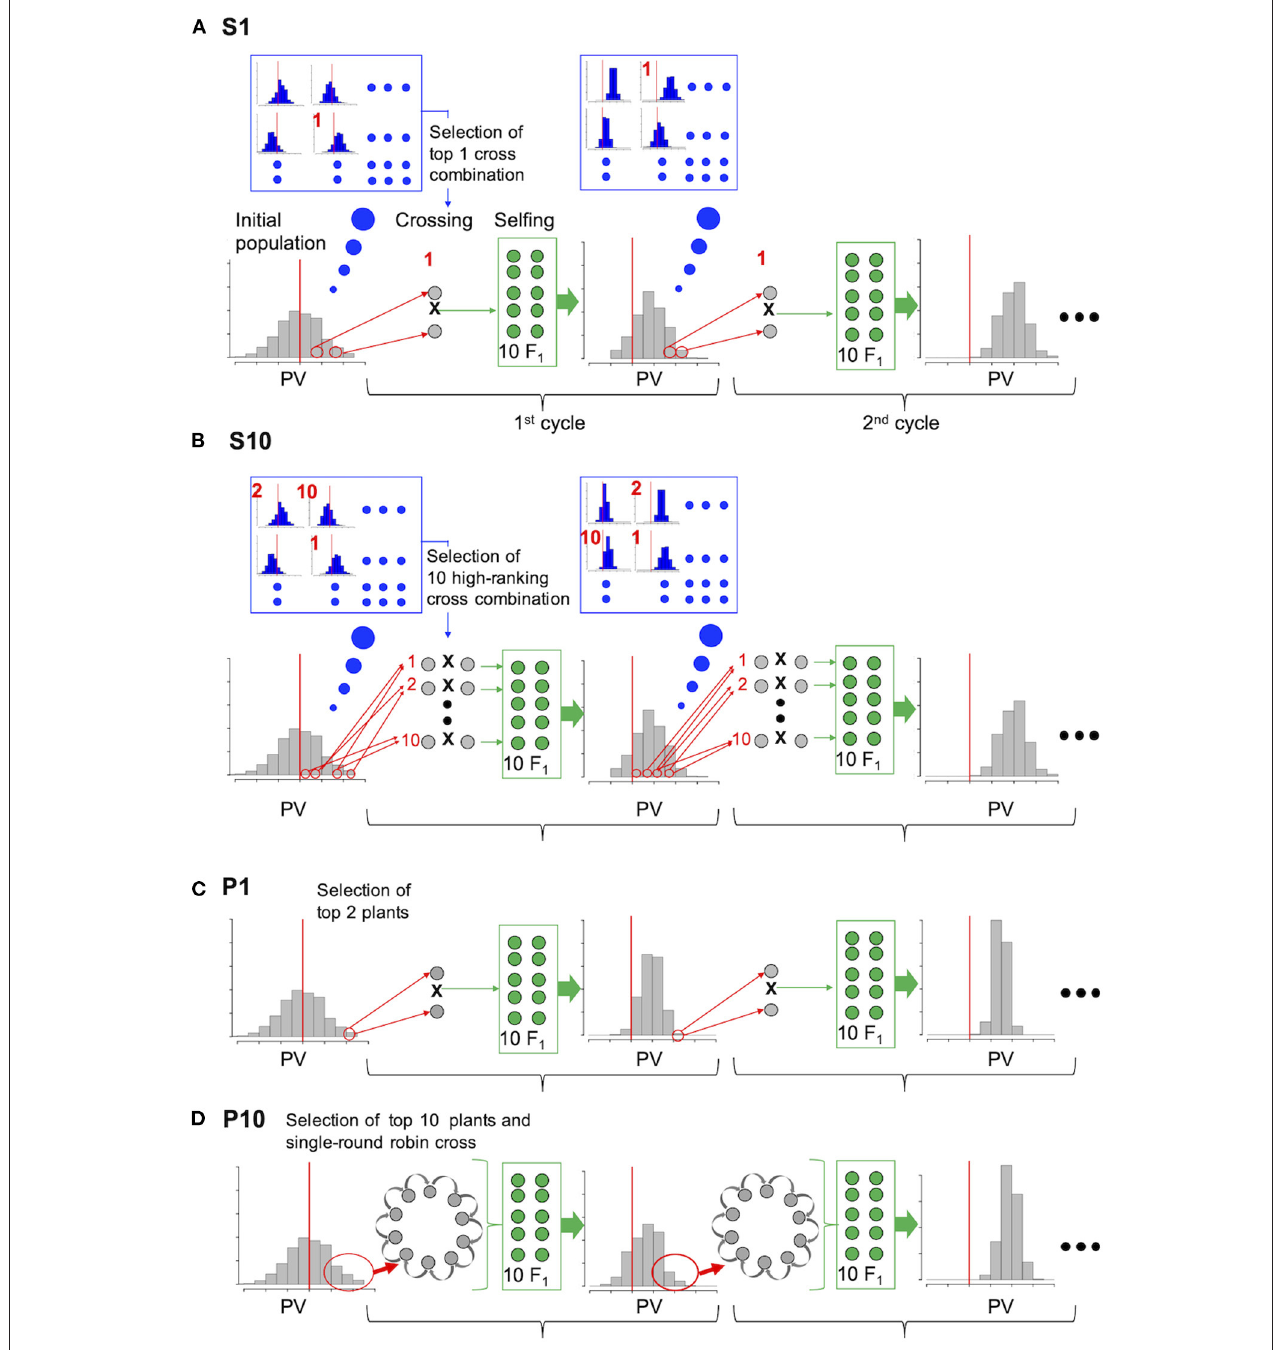
FIGURE 1 | Comparison of the selection strategies based on simulation experiment. (A) and (B) are the proposed strategies (S1, S10); genotypes of the initial population were used to simulate the distribution of prediction values (PVs) in the F 2 progeny (blue enlarged frame) for all possible cross combinations. Cross combinations are ranked according to the mean PV of the top 10 progeny, and crosses of only the top combination ( A , S1) or top 10 combinations ( B , S10) were conducted in each cycle. (C) P1: Top 1 and 2 plants were selected on the basis of their own PV and crossed in each cycle. (D) P10: Top 10 plants were selected on the basis of their own PV and crossed in a single-round robin design in each